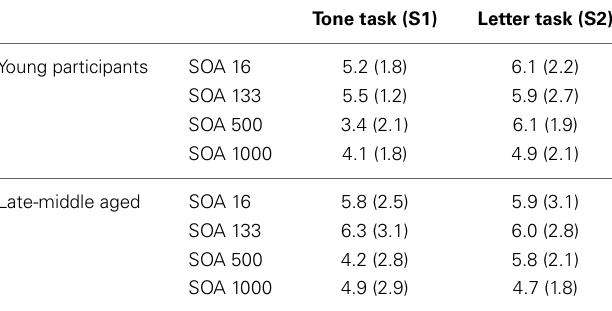
p = 0 . 060; SOA 1000: t (27) = − 1 . 70; p = 0 . 055]. The interaction